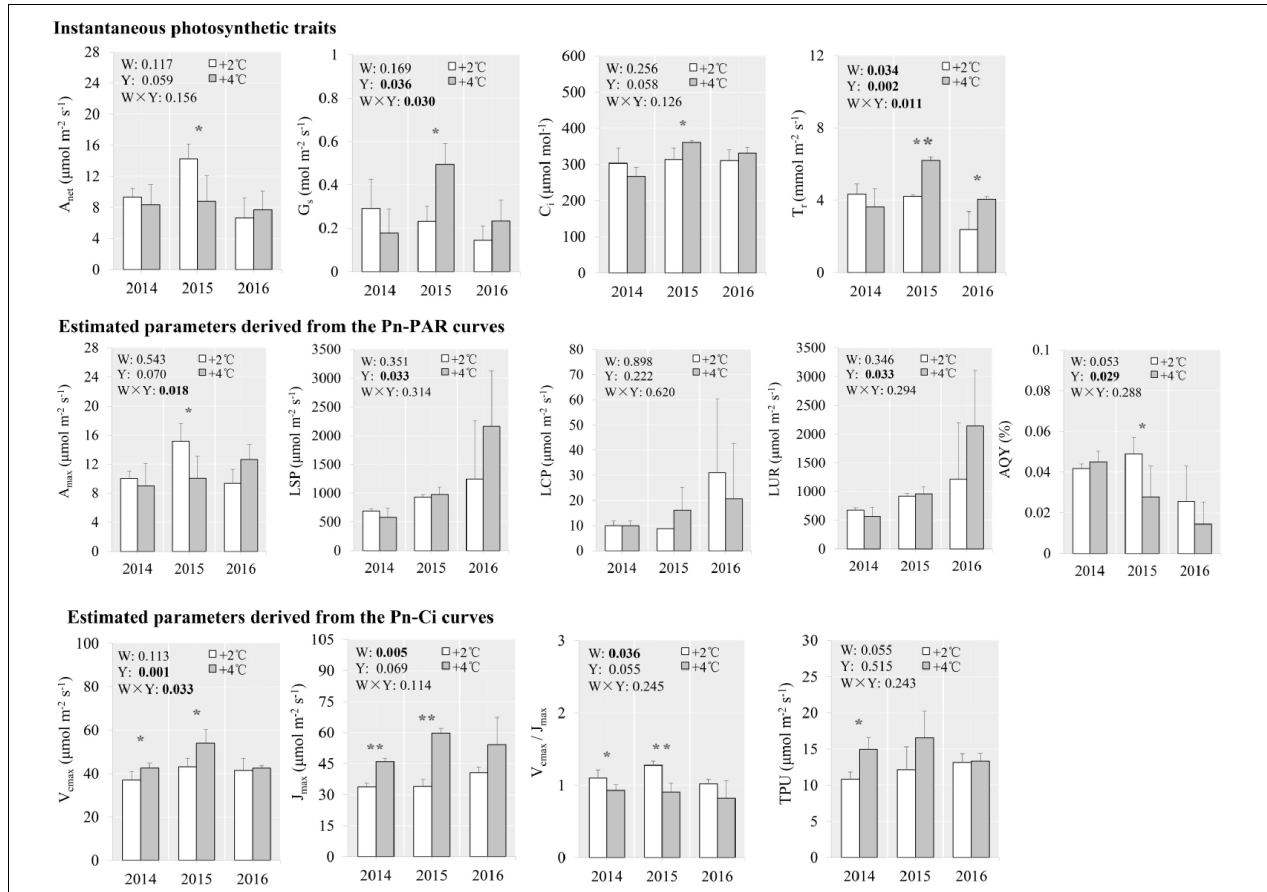
FIGURE 3 | Photosynthetic traits of S. tabernaemontani leaves under +2 ◦ C and +4 ◦ C warming scenarios using OTCs. Significance tests for warming ( W ), observed year ( Y ), and the interaction term ( W × Y ) under repeated-measures ANOVA are presented for each variable integrated across the different years ( p -values less than 0.05 are in bold). Within each year, variables that responded significantly to warming are indicated by asterisks (*** p < 0.001; ** p < 0.01; * p < 0.05). Error bars indicate standard deviations. See Figure 2 for descriptions of